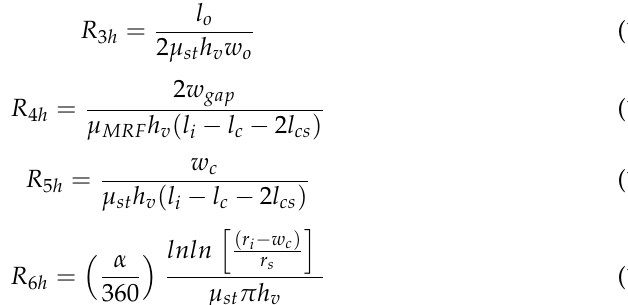
Figure 6. Electromagnetic circuit schematic: ( a ) Horizontal direction; ( b ) Vertical direction. The calculation of reluctance that moves horizontally (𝑅 (cid:2871)(cid:3035) – 𝑅 (cid:2874)(cid:3035) ) can be written into Equations (11)–(14).